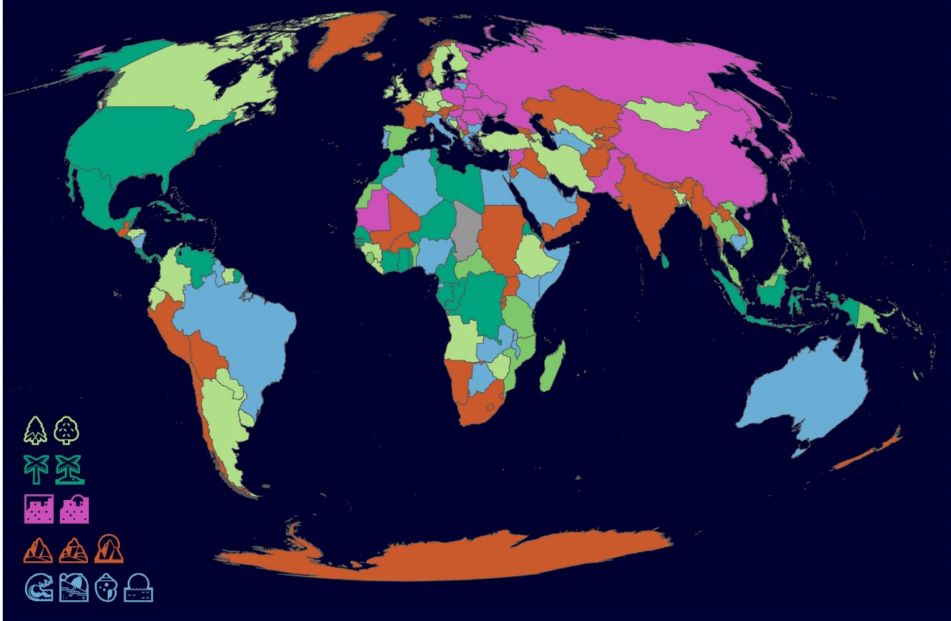
Figure 6. Countries by location-specific emojis calculated as typical, divided into environmen- tal